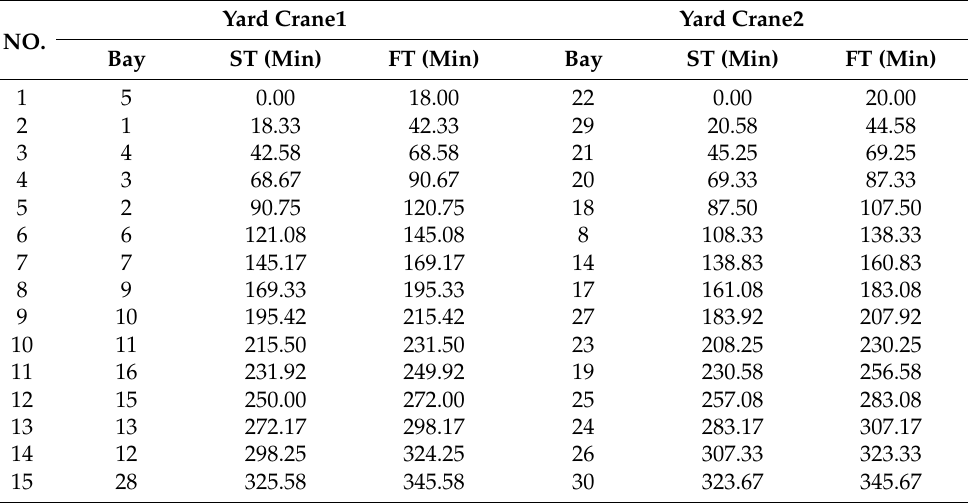
Figure 9. The solution of the second stage. ( a ) Convergence result of two yard cranes; ( b ) walking paths of two yard cranes. Table 3. Operating hours of two yard cranes.